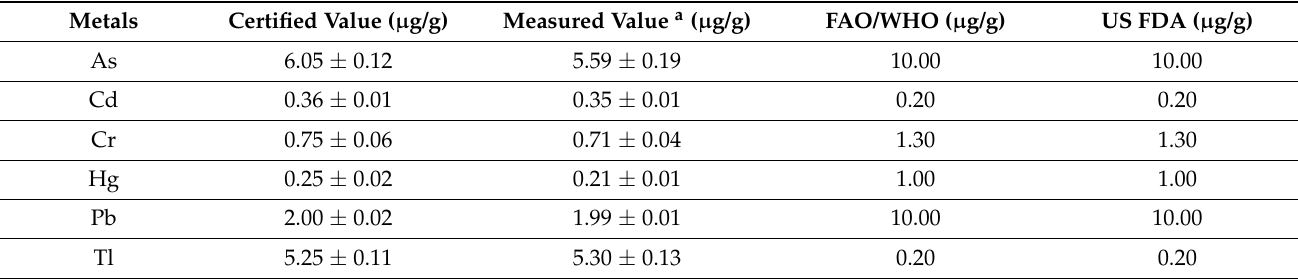
Table 2. Certified reference material and the determined values for the measured heavy